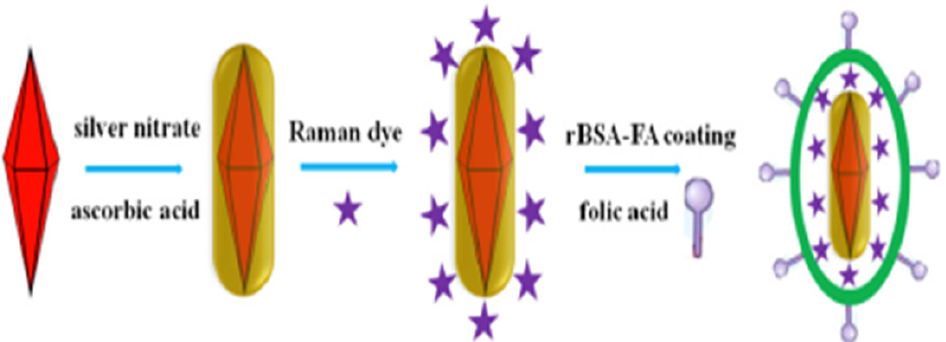
Figure 2. Illustration of fabrication of AuNBP@Ag NR-MBA-rBSA-FA nanoprobes [33]. Copyright Elsevier 2019.